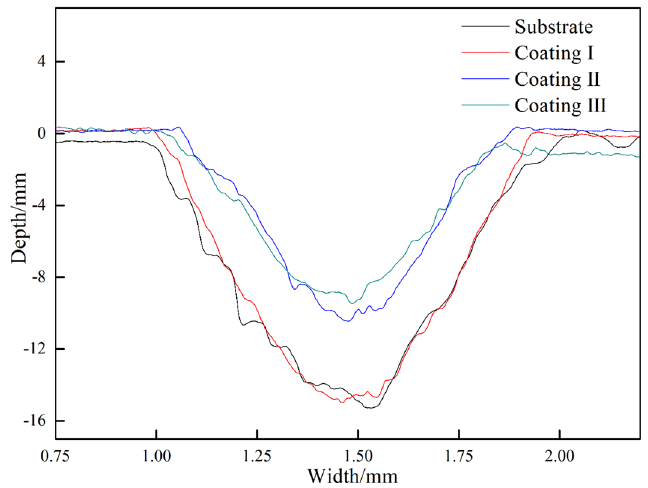
Figure 6. Worn profiles of the substrate and the coatings subject to friction in air. Table 3. Wear volumes and wear rates of the samples subject to friction in air and 3.5 wt.% NaCl solution.